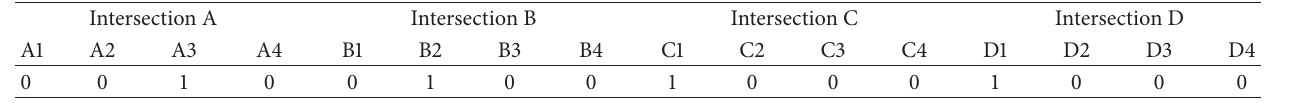
Table 1: An example of one